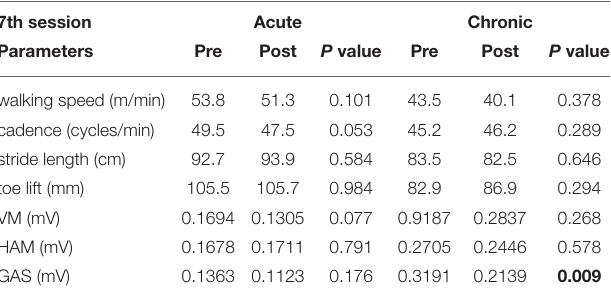
TABLE 8 | Comparison of integrated EMG of late to terminal swing phase during 10m walking test immediately before and after HAL intervention at the 7th HAL session, in acute and chronic stage